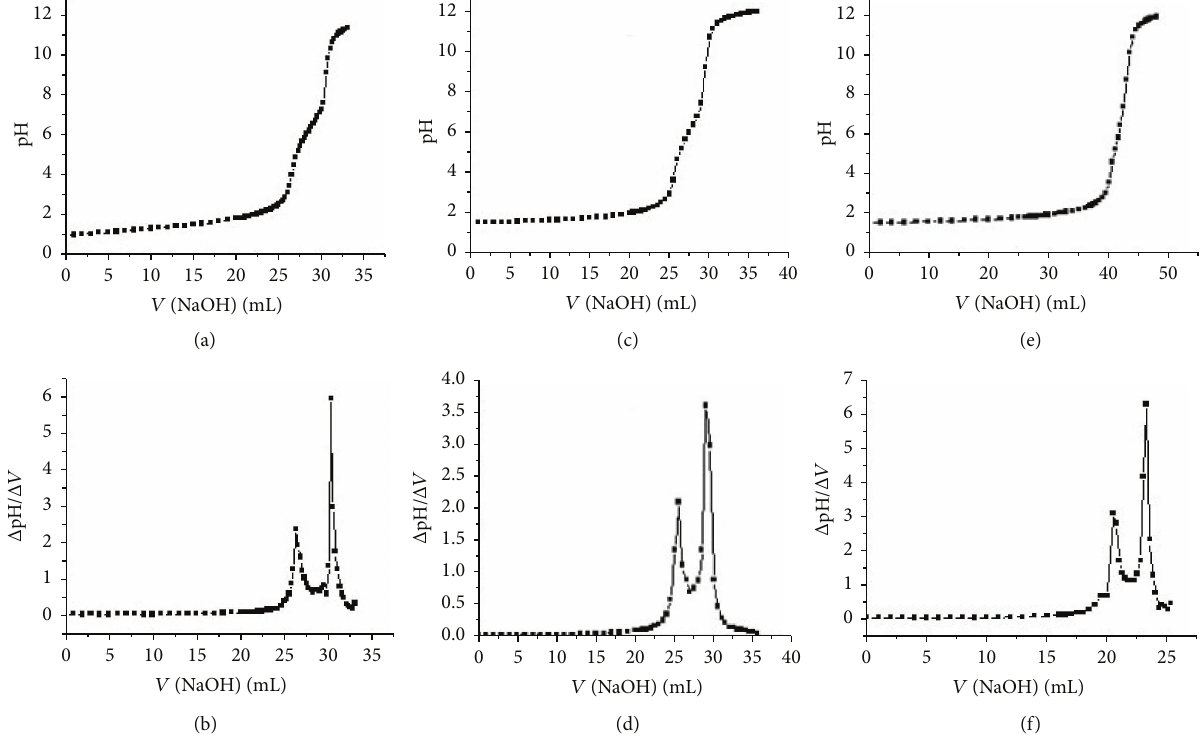
Figure 4: The DS of lactose in Lact-CTS by potentiometric titration method. The pH value titration curve of (a) Lact-CTS-1, (c) Lact-CTS-2, and (e) Lact-CTS-3. The first-derivative curves of (b) Lact-CTS-1, (d) Lact-CTS-2, and (f) Lact-CTS-3.